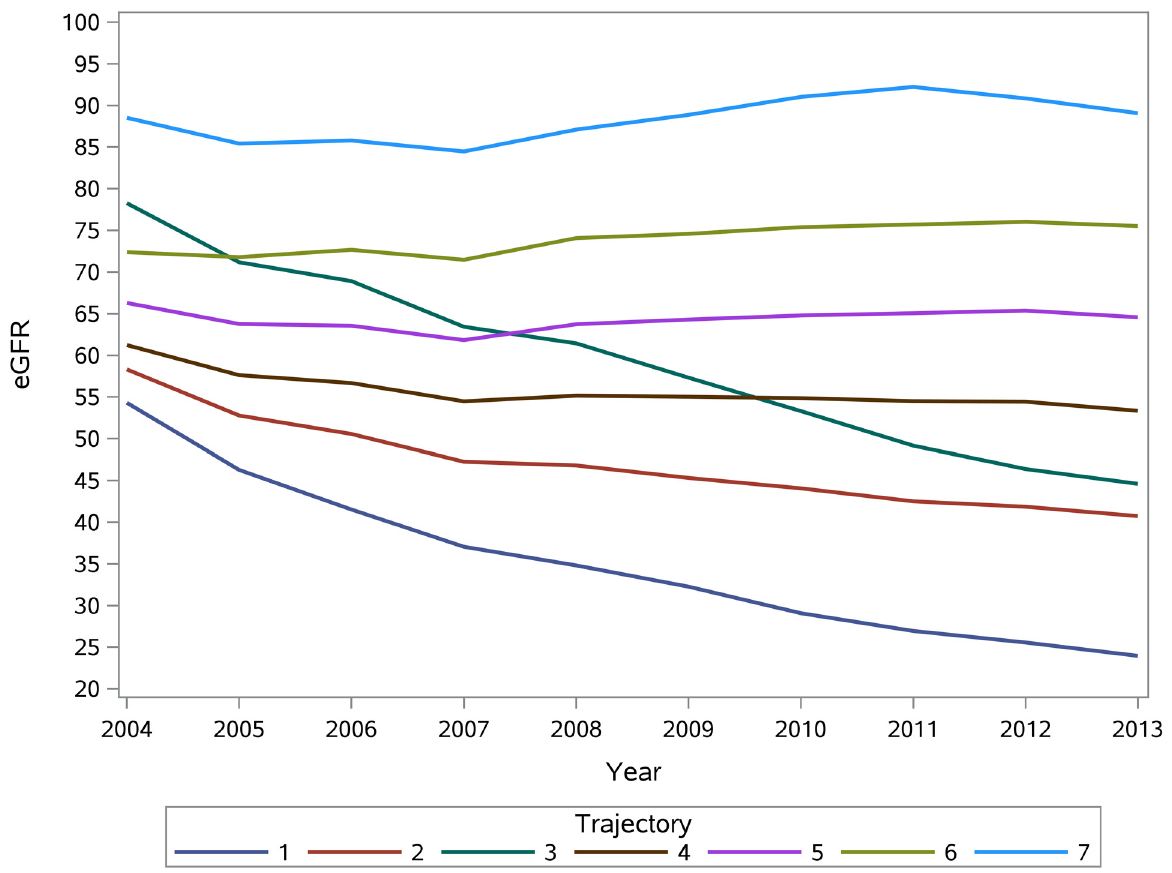
Fig 2. Renal function